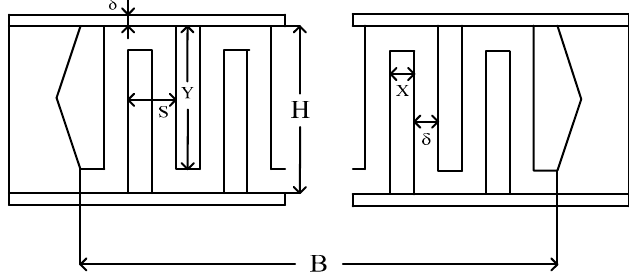
Figure 6. The geometry structure of the basic unit of plate-fin heat exchange.